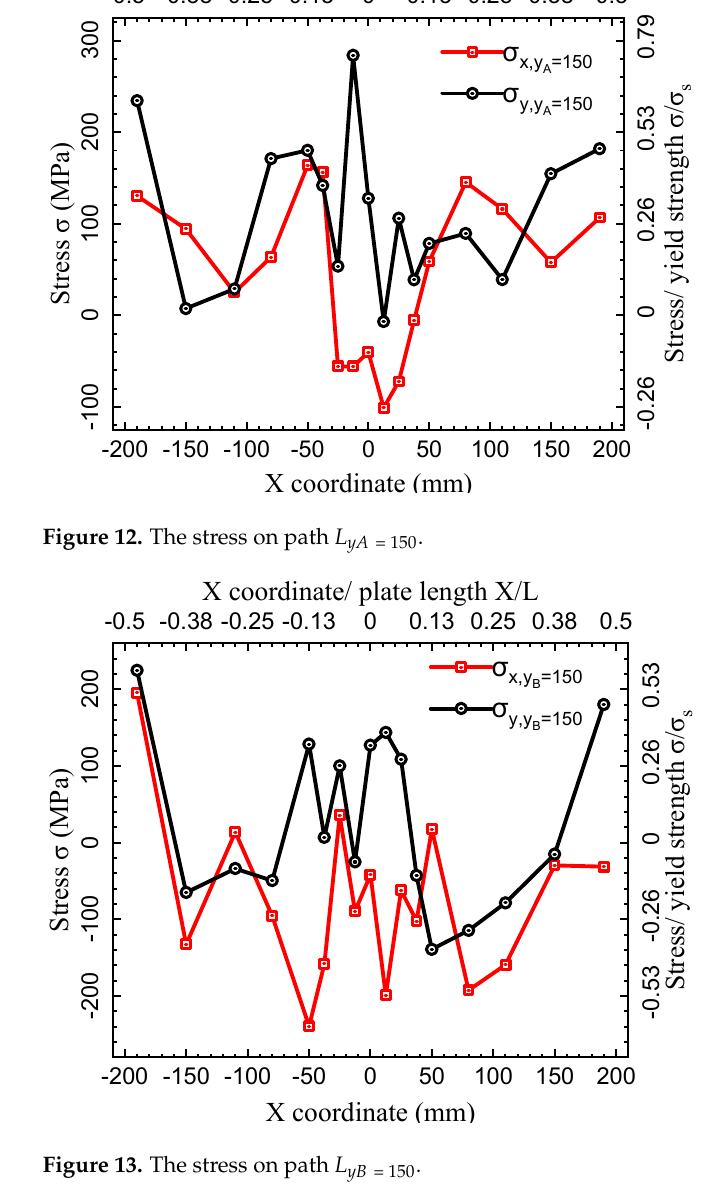
Figure 13. The stress on path 𝐿 (cid:3052)